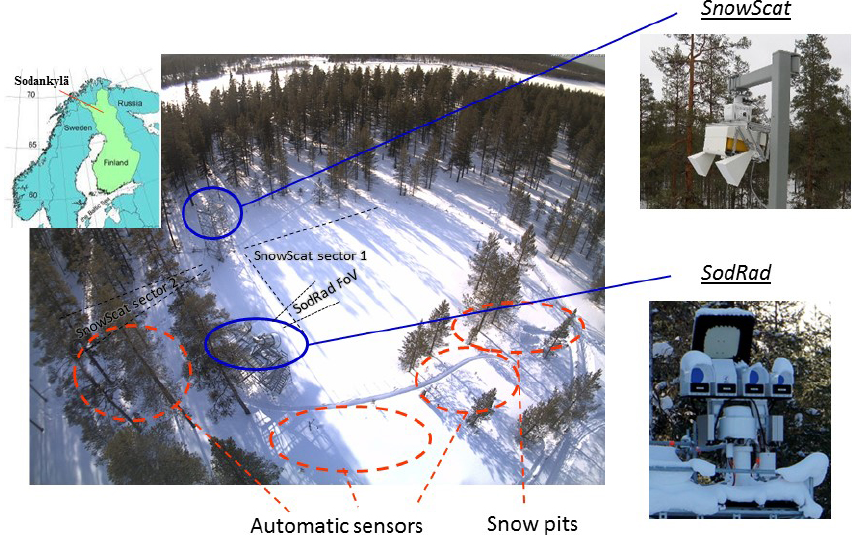
Figure 1. Webcam image of NoSREx IOA and photographs of main microwave instruments, the SnowScat scatterometer and the SodRad radiometer system.